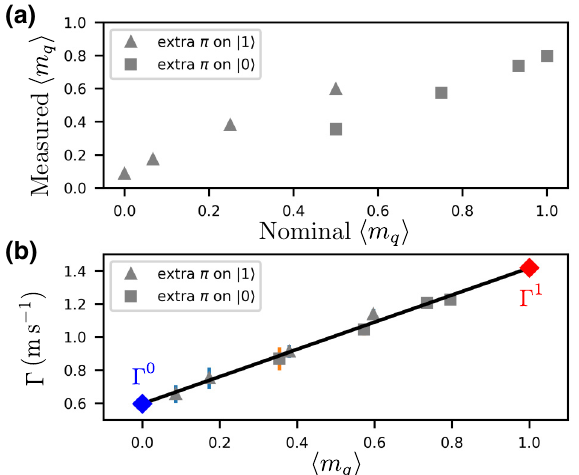
FIG. 9. (a) The average qubit-state measurement during the delay between parity measurements as a function of the nom- inal polarization angle θ ( (cid:5)/(cid:5) 0 = 0.335). The observed (cid:9) m q (cid:5) deviates from the nominal value (cid:9) m q (cid:5) = sin 2 (θ/ 2 ) due to energy relaxation as well as the large detuning between the carrier fre- quency of the qubit pulse and the even- and odd-parity qubit frequencies. (b) The charge-parity-switching rate (cid:4) as a function of the average qubit-state measurement during feedback between parity measurements [Fig. 2(b)]. For each of the eight measure- ments of (cid:4) (gray), a different state ψ(θ) is prepared after each qubit measurement m q . The triangles represent measurements for which, during feedback, the qubit is π pulsed if it is in | 1 (cid:5) , fol- lowed by rotation to ψ(θ) . The squares represent measurements for which, during feedback, the qubit is π pulsed if it is in | 0 (cid:5) , followed by rotation to ψ(θ) . Both sets of measurements are fit- ted to a single line in order to determine (cid:4) 0 (blue diamond) and (cid:4) 1 (red